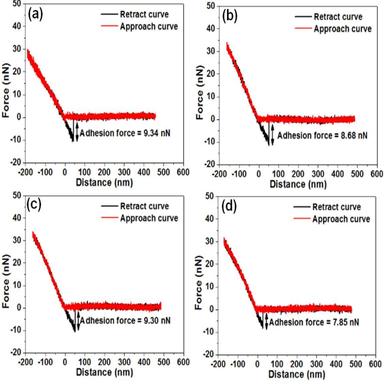
(a)-(d) Force-distance curves (approach and retract) corresponding to cross-points (a) to (d) in b) of the GAC sample.